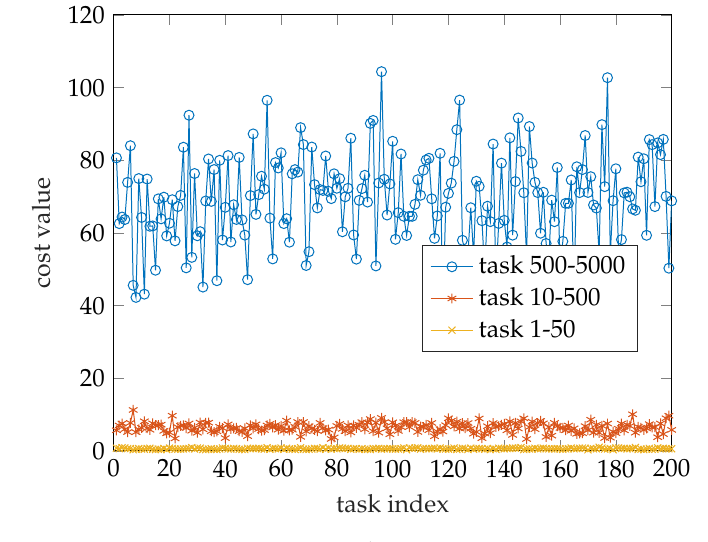
Figure 4. Cost value comparison.